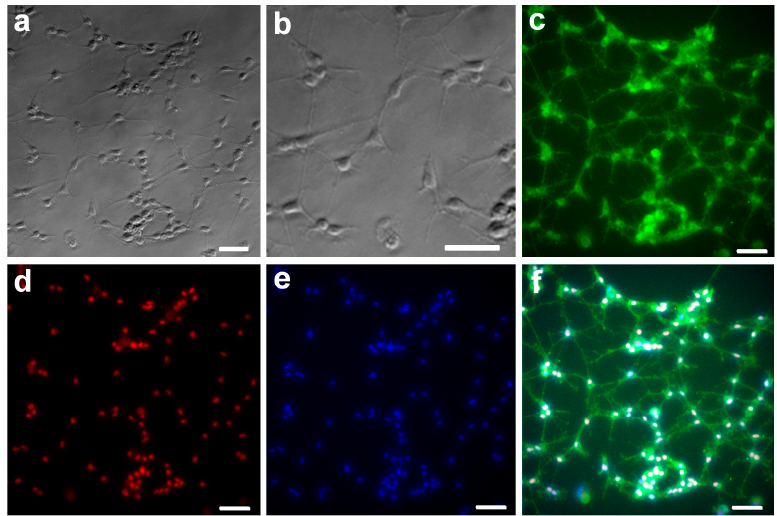
Figure 1. Identification of isolated rat oligodendrocyte progenitor cells (OPCs). OPCs typically display a bipolar/tripolar morphology, with little evidence of secondary branching 3 days after isolation ( a ). Higher magnification of ( a ) allows smaller, developing processes to be picked out ( b ). OPCs are characterized as immunopositive for A2B5 ( c , green ) and Olig2 ( d , red ). Nuclear counter-staining of OPCs with DAPI ( e , blue ). The DAPI channel is combined with the A2B5 and Olig2 channels ( f ). Scale bars = 50 μ m.